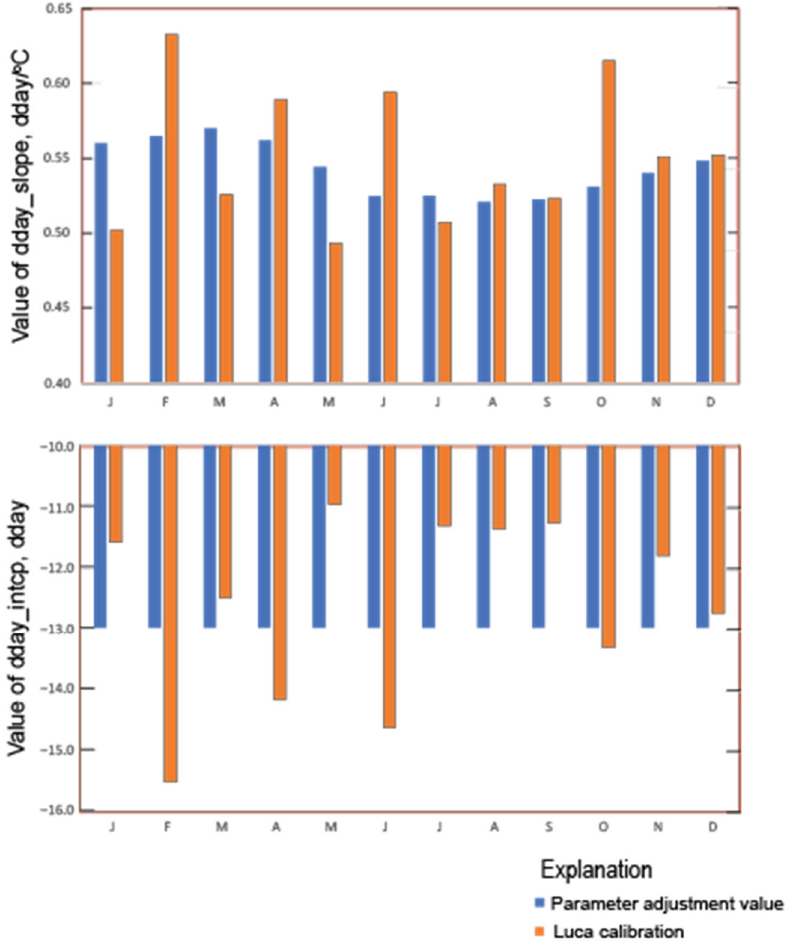
Figure 10. Degree-day solar radiation parameters dday_slope and dday_intcp before and after Luca Figure 10. Degree ‐ day solar radiation parameters dday_slope and dday_intcp before and after Luca calibration step calibration step 1.